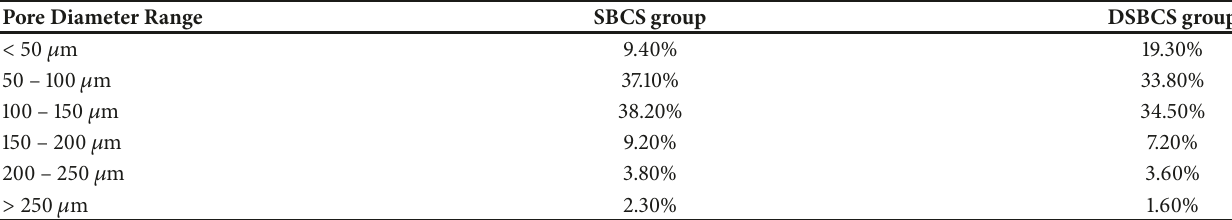
Table 1: Pore diameter distribution within SBCS group and DSBCS group.